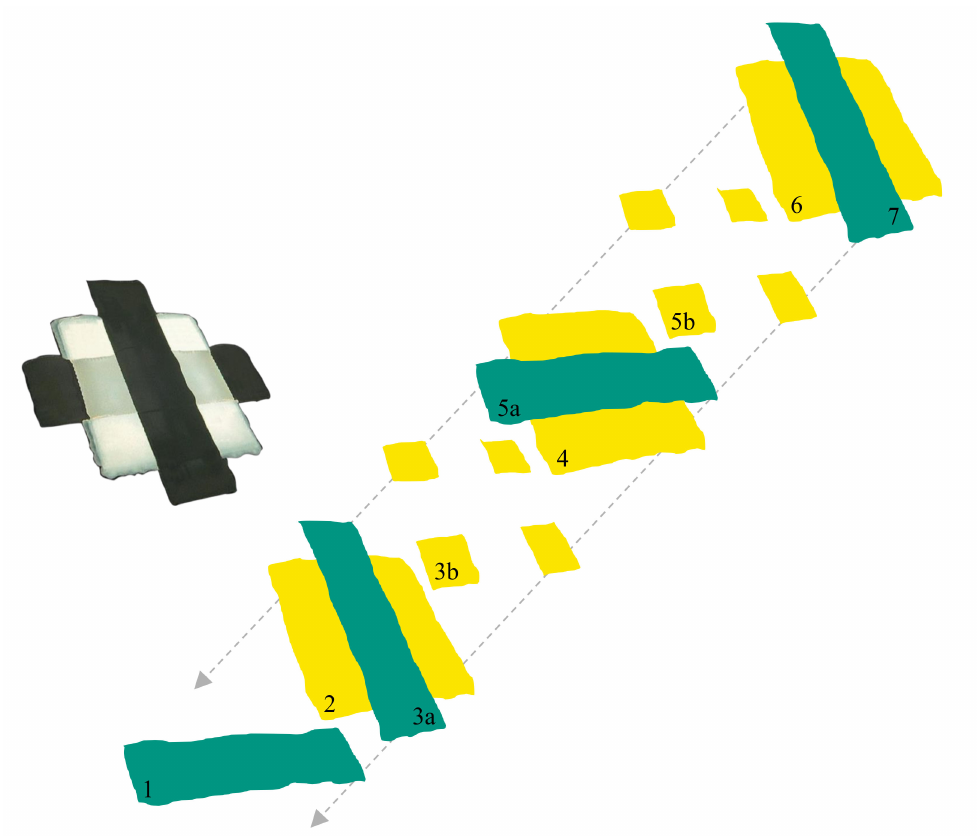
Figure 1. Microscope image (left) and schematic diagram (right) of a multilayer capacitor with three dielectric layers (yellow) and four Ag-electrodes (green). (1) First electrode; (2) First dielectric layer; (3a) Second electrode; (3b) Supporting structure; (4) Second dielectric layer; (5a) Third electrode; (5b) Supporting structure; (6) Third dielectric layer; (7) Fourth